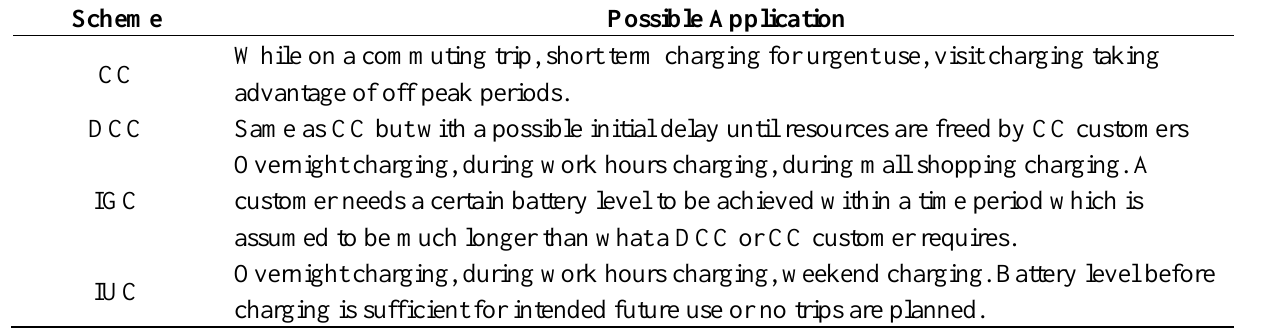
Table 1. Charging schemes with possible